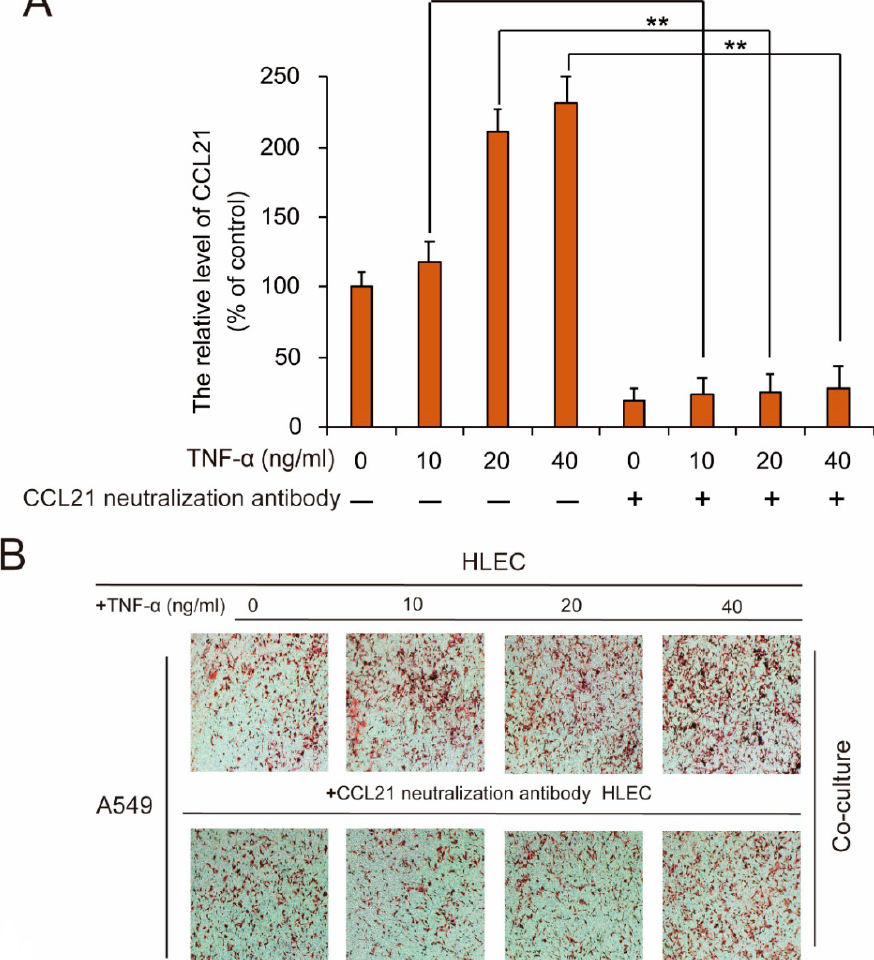
Figure 5. HLEC co-culture-induced metastasis and invasion of A549 cells is CCL21 dependent. HLEC were pretreated with or without the indicated concentrations of CCL21 neutralization antibody, and then exposed to different concentrations of TNF- α (10, 20, and 40 ng/mL) for 48 h. ( A ) Confirmation of the neutralized efficiency of CCL21 secretion was detected by ELISA analysis in HLEC. Data represent the mean ± S.E.M. from three independent experiments. Asterisks denote statistically significant (* p < 0.05 and ** p < 0.01) differences compared with controls by one-way ANOVA. ( B,C ) Afterwards, HLEC were exposed to the CCL21 neutralization antibody and different concentrations of TNF- α (10, 20, and 40 ng/mL) for 48 h, then the CCL21 neutralization antibody and TNF- α were